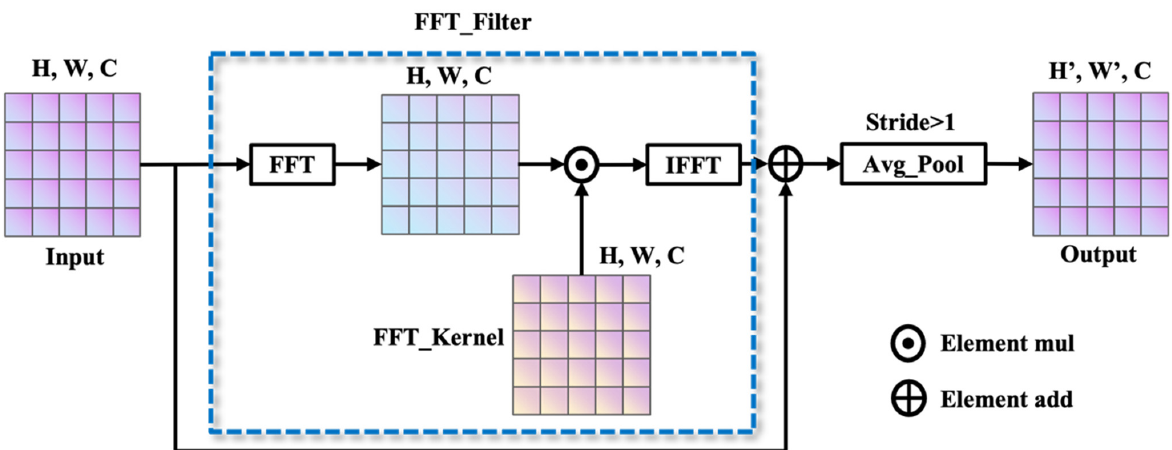
Figure 2. The architecture of FFT_filter.